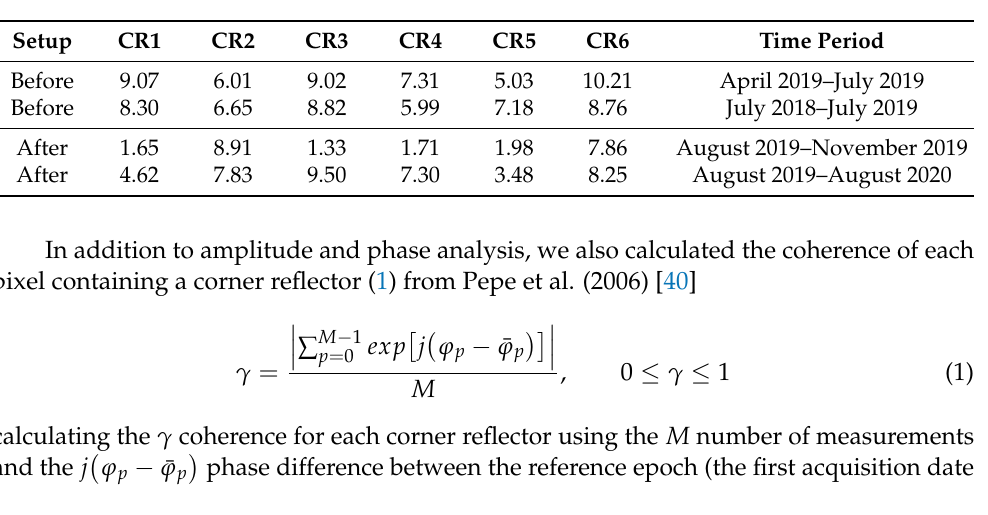
Table 1. Standard deviation of displacement accuracy (mm) values corresponding to each pixel with a corner reflector in it. We show these results over a four month period (top rows) and over a year (bottom rows) before and after the installation of the corner